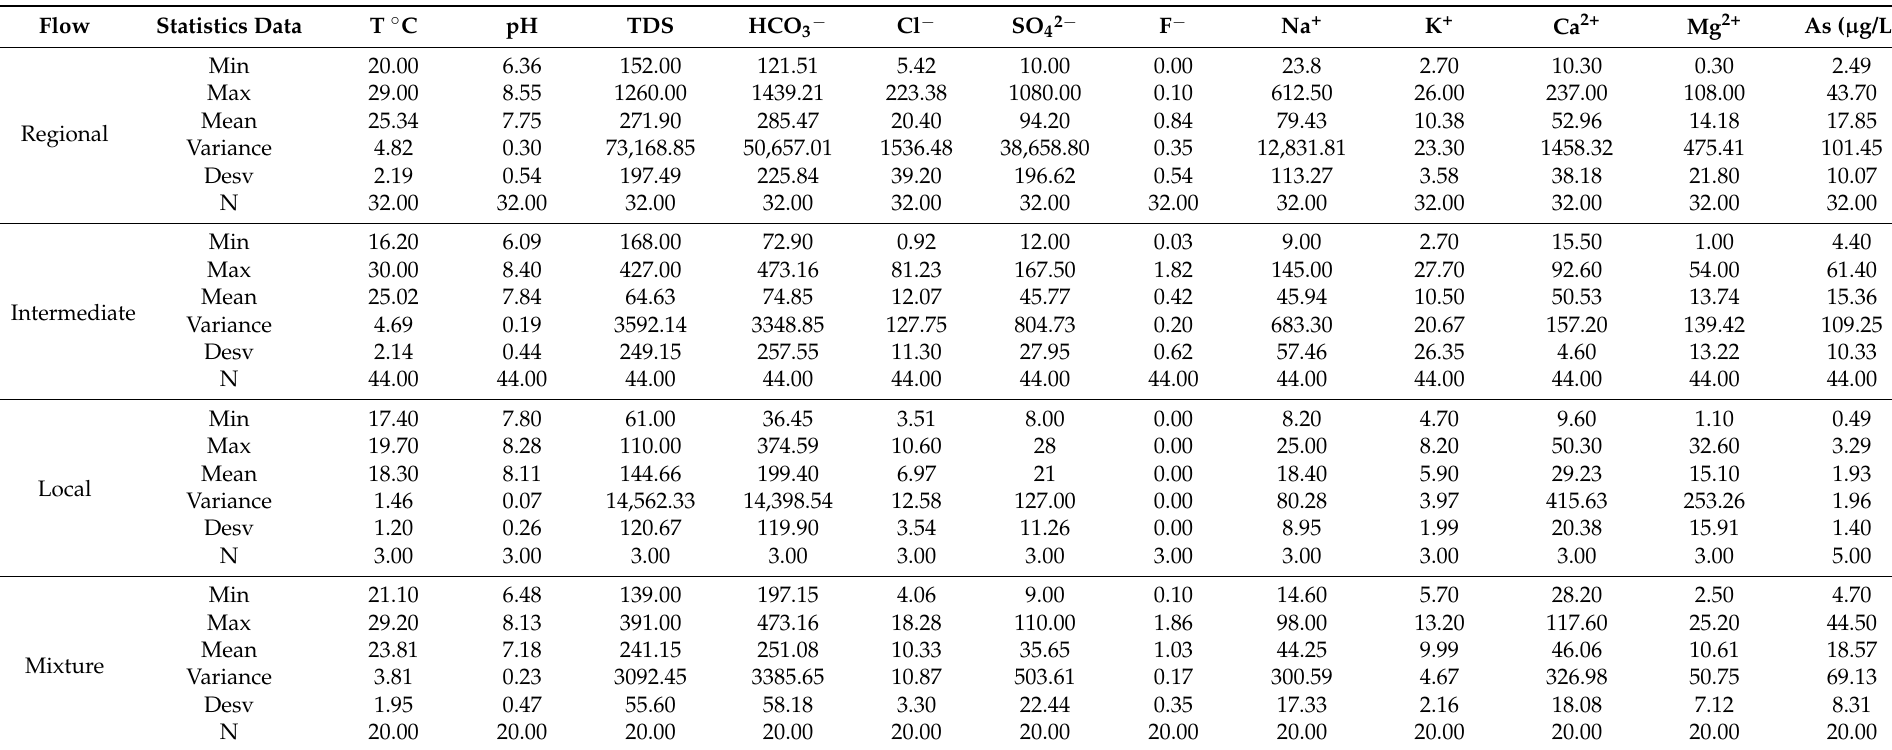
Table 4. Clustering of flows as a result of cluster analysis for the year 2005 (TDS = total dissolved solids, concentration mg/L; modified from Avila et al., 2018 [43]).